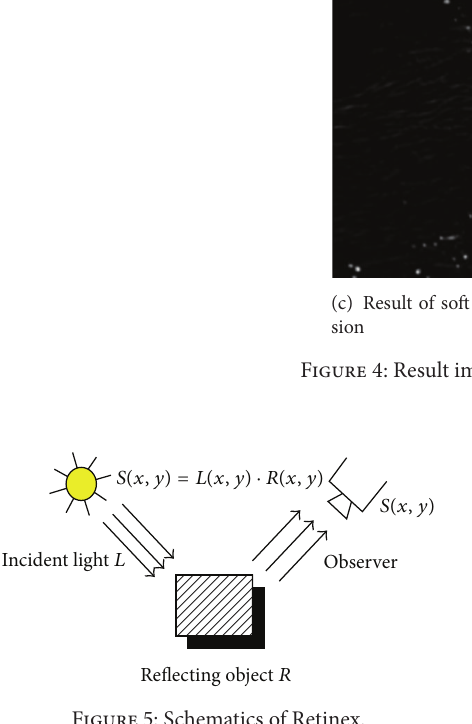
Figure 5: Schematics of